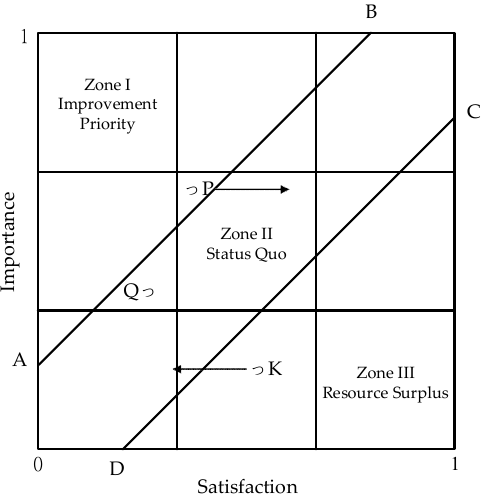
Figure 2. Controlled Performance Evaluation Matrix (PEM) [25].